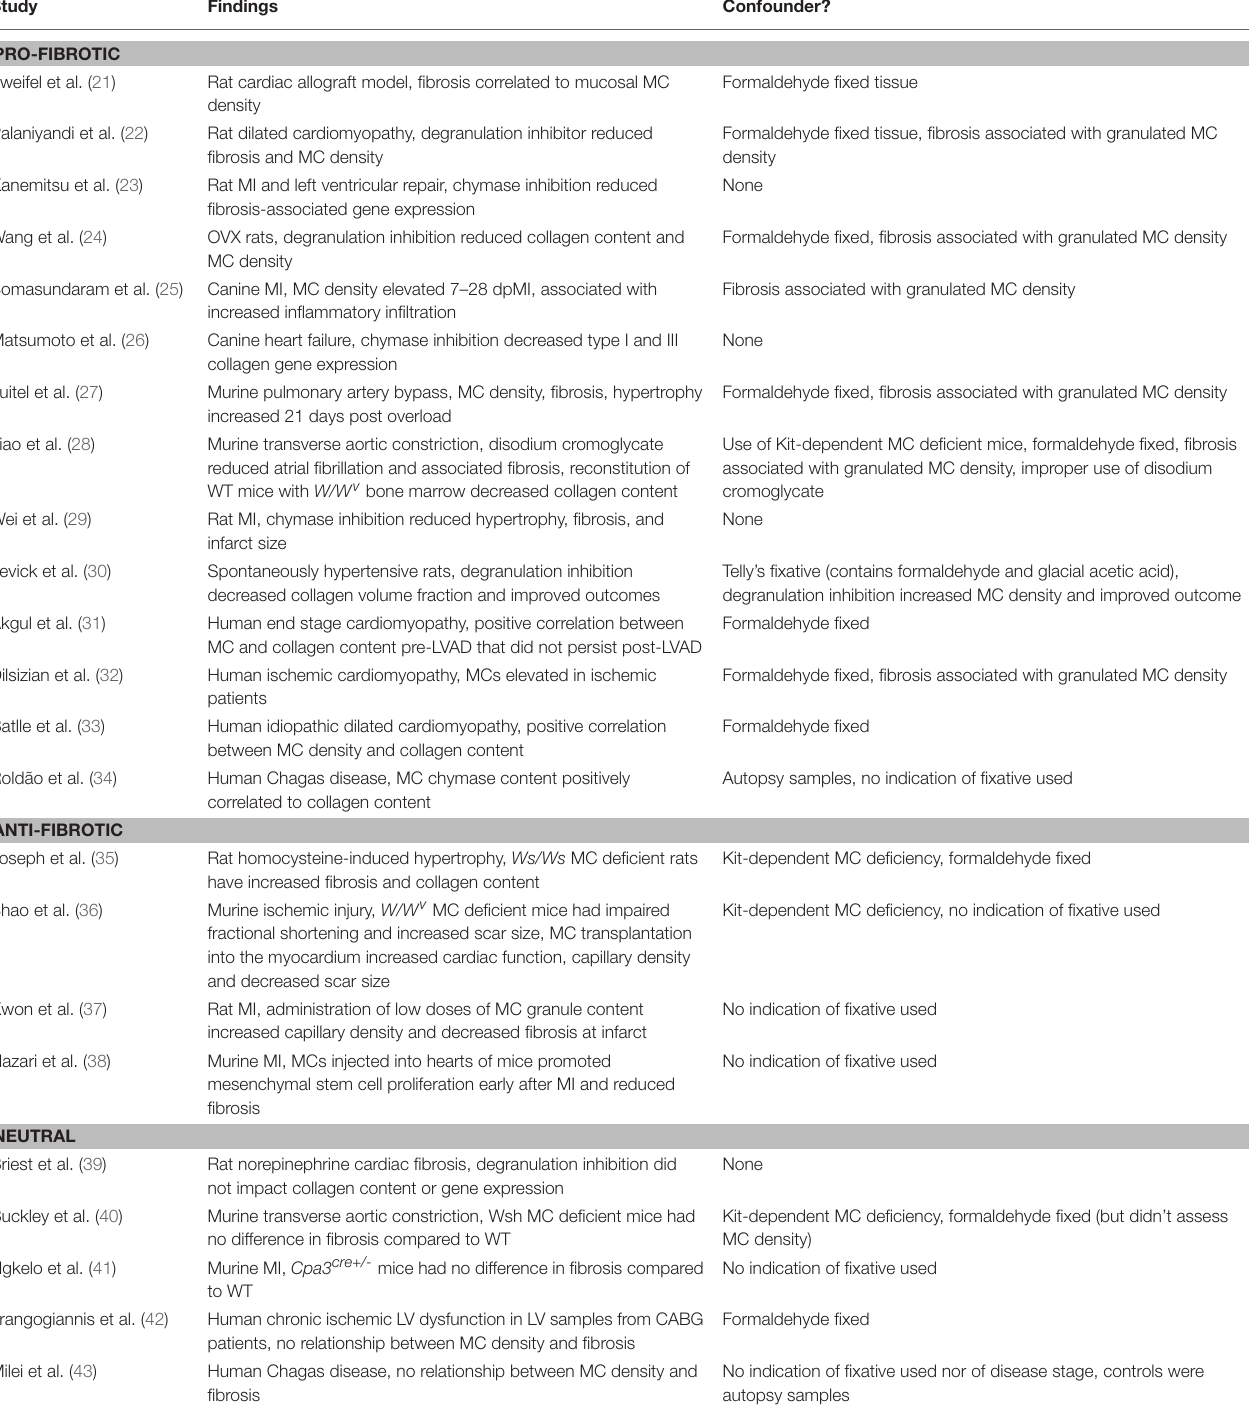
TABLE 1 | The role of mast cells in animal models of cardiac